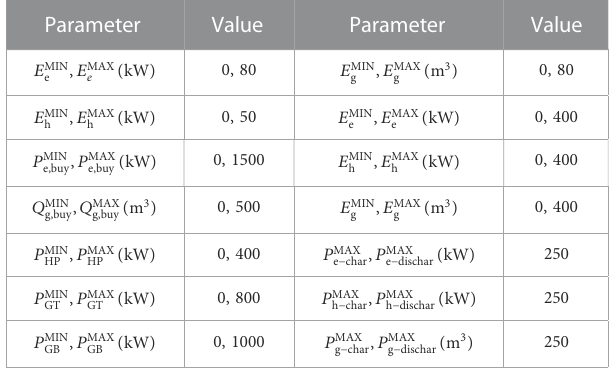
TABLE 1 Parameters of the variables.